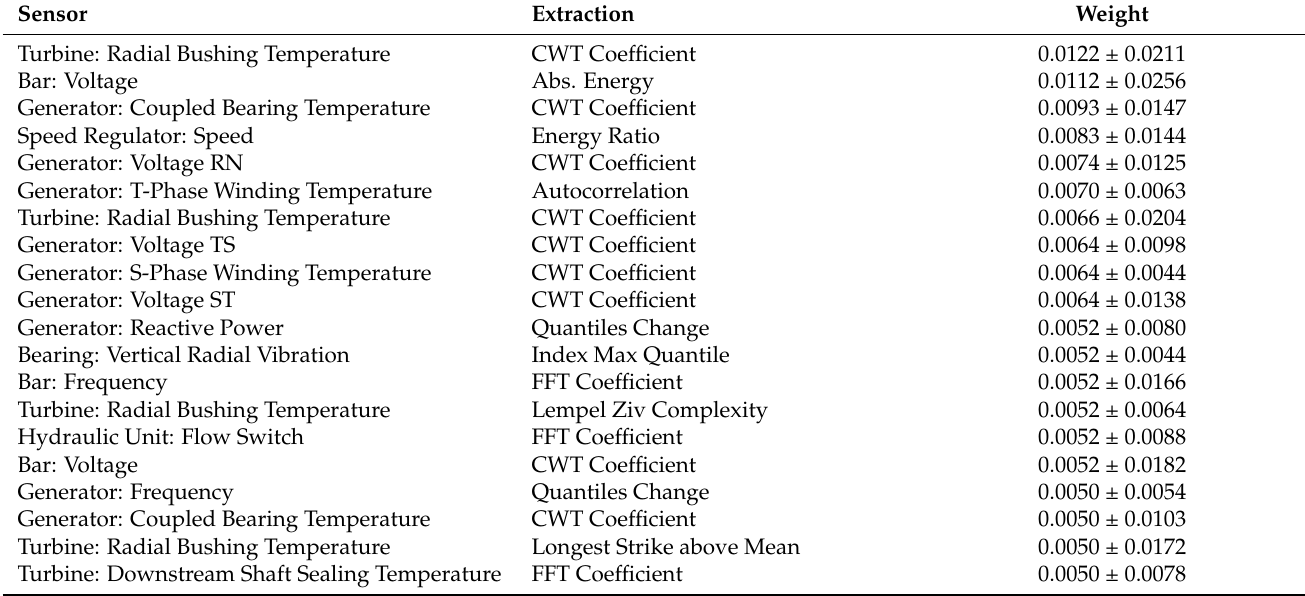
Table 7. The 20 most important features of the TSF-RSF group by permutation importance. Column weight represents the average increase in the C-index when the feature is